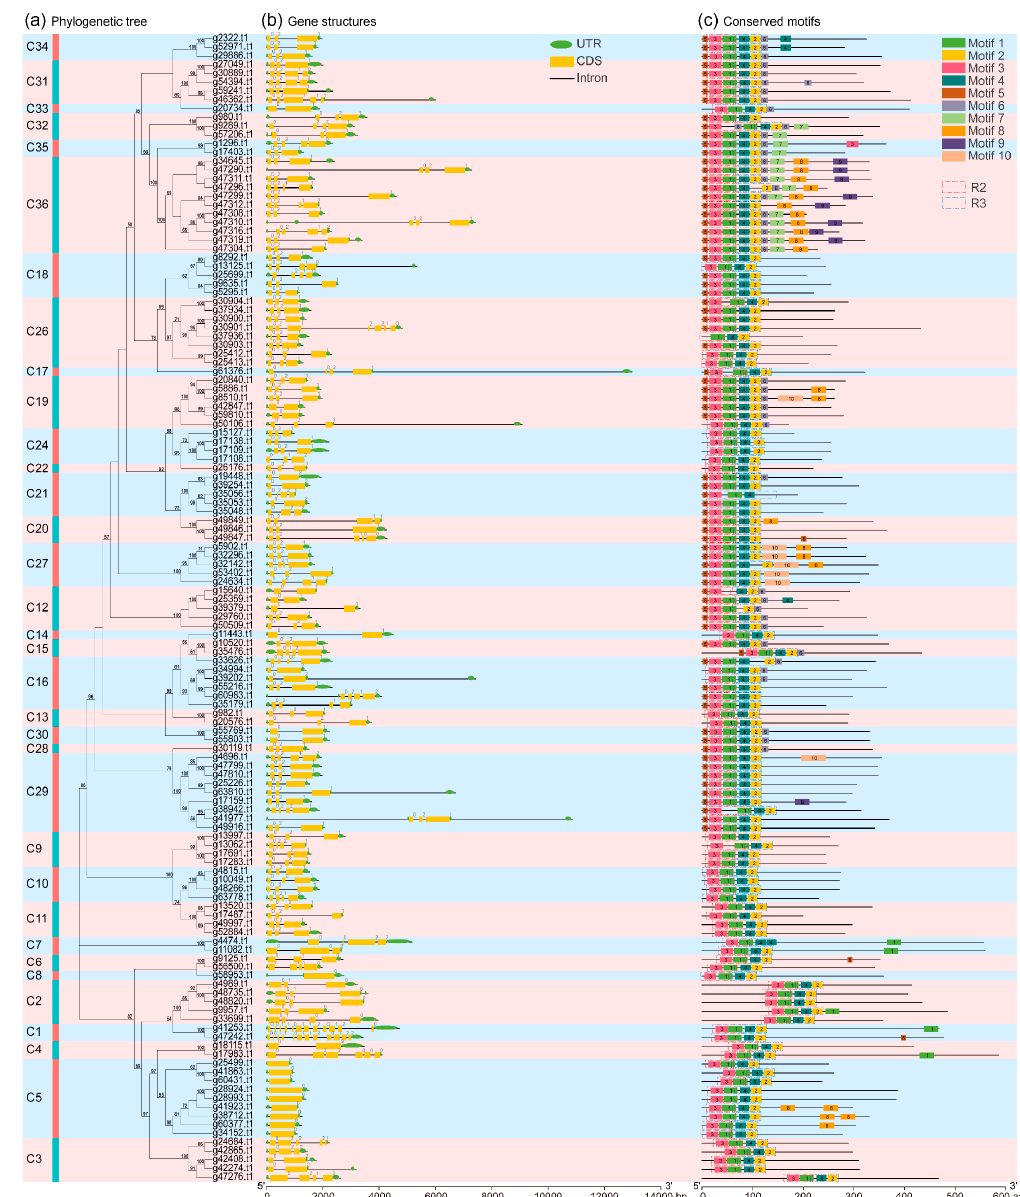
Figure 6. Phylogenetic relationships, exon-intron structures, and conserved motifs of the R2R3-MYB genes in sweet potatoes. ( a ) The phylogenetic tree of the 131 IbR2R3-MYB proteins. The tree was constructed by the maximum-like (ML) method of IQ-tree with 1000 bootstrap replicates. ( b ) The gene structure of the 131 IbR2R3-MYB genes. The yellow boxes, green ellipses, and black lines rep- resent exons, untranslated regions (UTR), and introns, respectively. The bar scale at the bo tt om shows the length of the gene. ( c ) The conserved motifs of the 131 IbR2R3-MYB proteins. The boxes with di ff erent colors represent Motif 1–10, and the black solid line represents non-conserved re- gions. While the dashed boxes represent the R2 and R3 domains, their sequences logo shown in Figure S1. The bar scale at the bo tt om shows the length of the amino acids. In this study, 10 conserved motifs, among 131 IbR2R3-MYB proteins, were further identi fi ed and named Motif 1 to Motif 10 (Figures 6c and S2). R2R3-MYB proteins cluster-